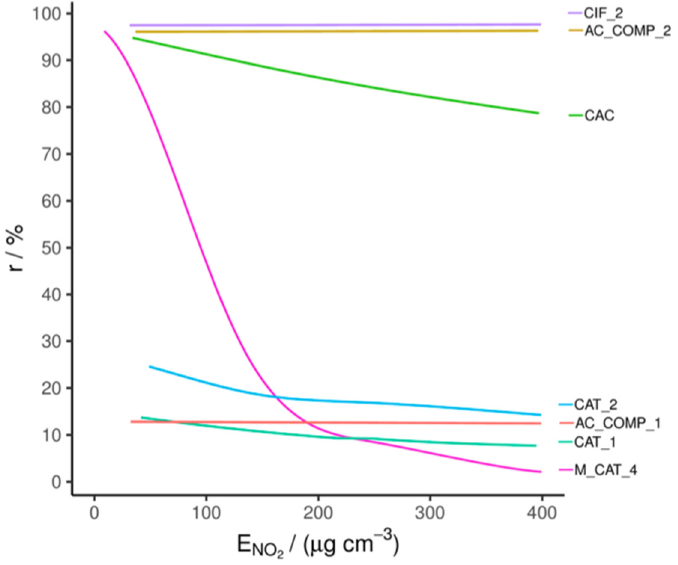
Figure 3. Single ‐ pass NO 2 removal efficiency comparison. Figure 3. Single-pass NO 2 removal e ffi ciency